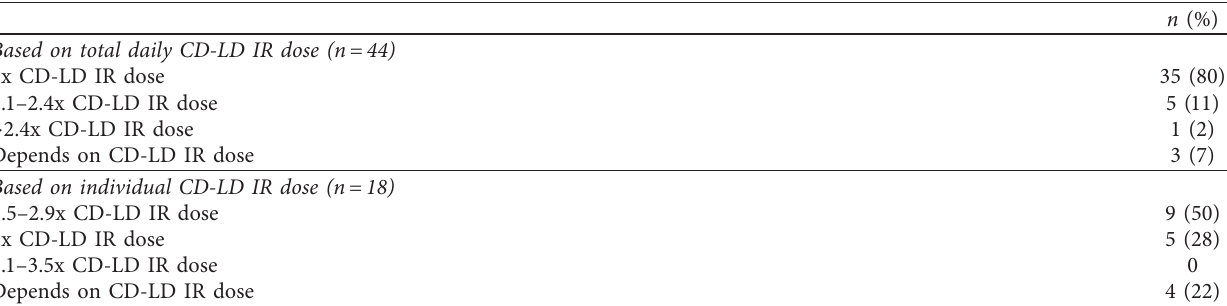
Table 3: CD-LD IR to CD-LD ER dose conversion